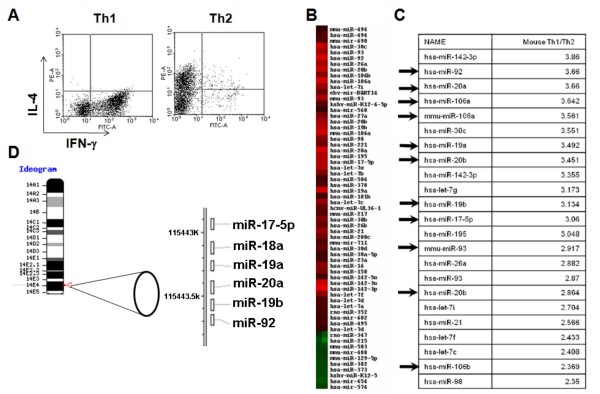
Microarray analysis demonstrates up-regulation of miR-17-92 in Th1 cells. (A), Intracellular IFN-γ vs. IL-4 expression of Th1 and Th2 cells induced from mouse CD4+ splenic T cells in vitro. (B), Differentially expressed miRs were analyzed by hierarchical clustering of the log2 value of Th1/Th2 pair of miR microarray signal. Red indicates up-regulation in Th1; green, up-regulation in Th2. (C), miRs were ranked by relative fold expression in Th1/Th2 cells. Arrows indicate members of the miR-17-92 cluster or paralog clusters. miRs with a relative expression of >2.35 fold in Th1 are shown. (B and C), hsa- and mmu- indicate human and mouse miR probes, respectively. Hsa-probes can hybridize with most mouse miR due to the high homology and mmu-signals are shown only when murine miR has unique sequence compared to its human counterpart. (D), Ideogram of mouse chromosome 14 showing the location and order of the miR-17-92 cluster (adapted from NCBI Blast).